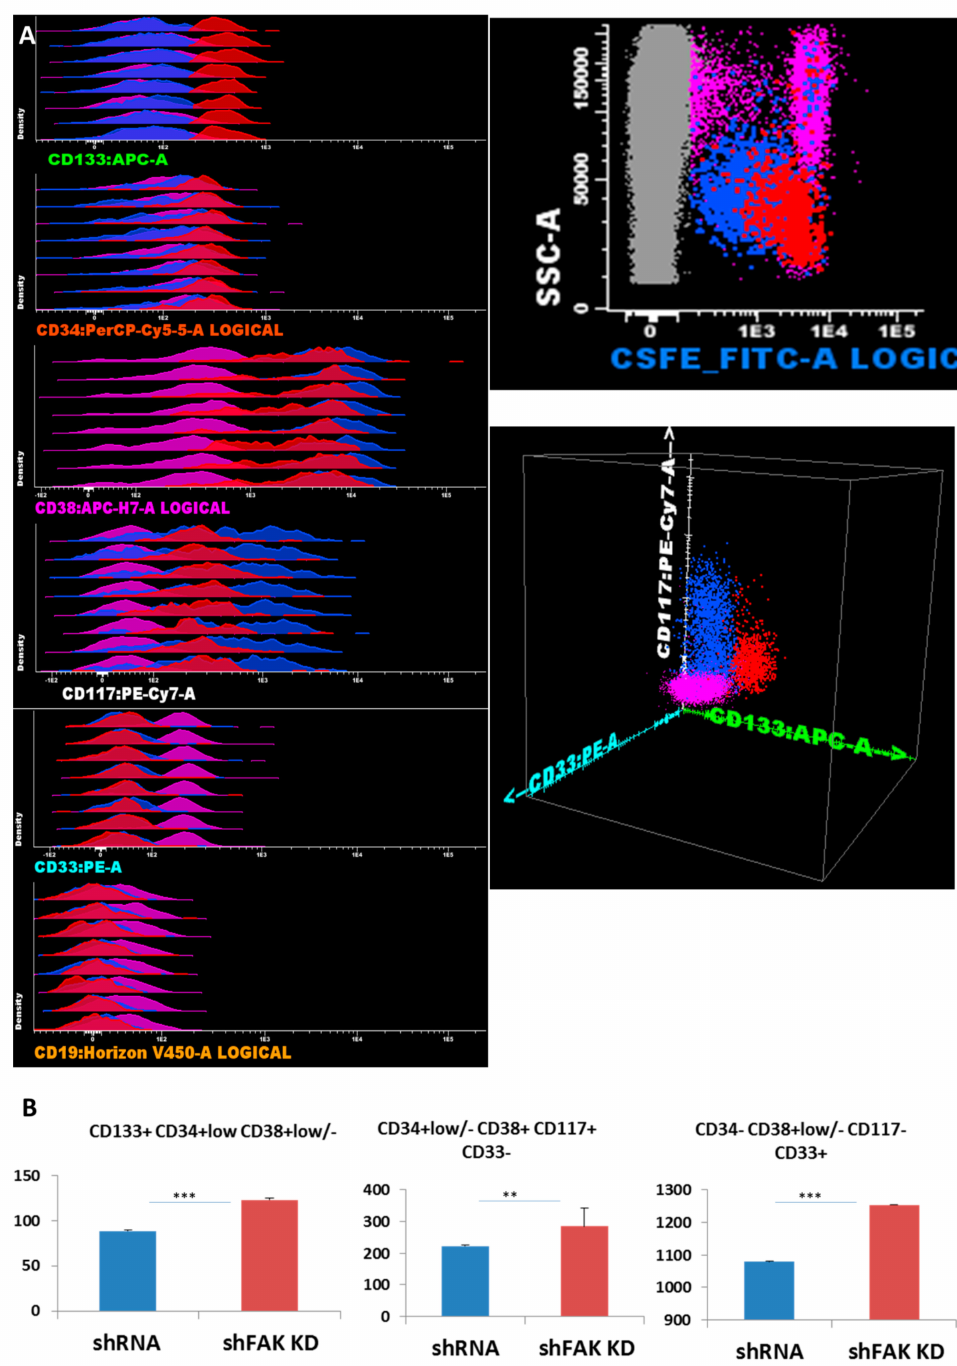
Figure 4. FAK deficiency in HS-5 cells promotes the proliferation of CD34 + HD-HSPCs cells in short-term co-cultures ( A ) Reliable discrimination between the HS-5 cells (grey dots) and CFSE-labelled CD34 + HD-HSPCs (red, blue, and pink dots). Evaluation of HSPCs’ compartment using immature stem cells markers and di ff erentiation antigens. Three main populations are observed: The immature HSPCs CD133 + CD34 + low CD38 + var CD117 + low CD33- CD19- (red dots) and more mature HSPCs CD133- CD34- can be divided by CD38 into two separate subpopulations: CD117 + CD38 + CD33- CD19- (blue dots) and CD38- CD117- CD33 + CD19- (pink dots). ( B ) Absolute cell count of HD-HSPCs recovered after five days of co-cultures between CD34 + HD-HSCs and HS-5 cells (shFAK cells or control shRNA; n Control shRNA = 3, n shFAK = 3). p < 0.01(**); p <